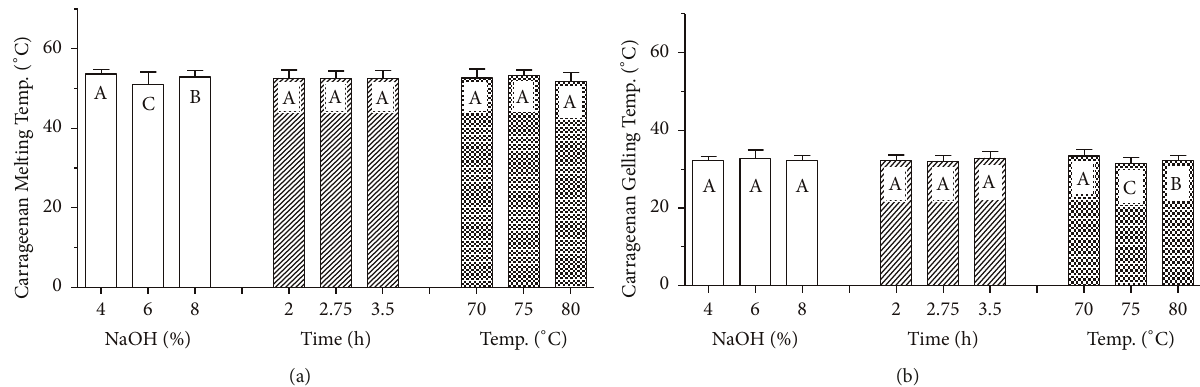
Figure 5: Effect of different parameters of alkaline pretreatment on carrageenan melting (a) and gelling temperatures (b).